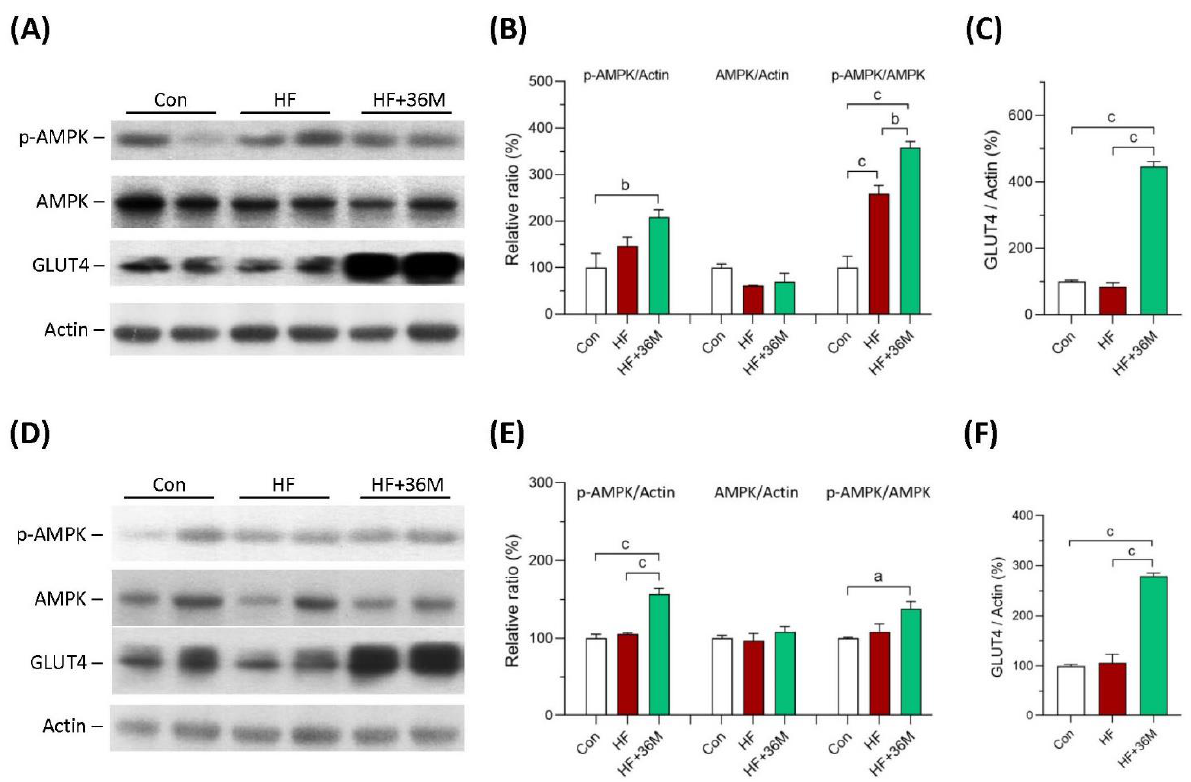
Figure 5. Protein expression of AMPK and GLUT4 in skeletal muscle of the mice. ( A ) The repre- sentative immunoblot images for p-AMPK, AMPK, GLUT4, and β -actin proteins of the mice in the prevention model. ( B , C ) The quantified results of the blots. ( D ) The representative immunoblot images for p-AMPK, AMPK, GLUT4, and β -actin proteins of the mice in the treatment model. ( E , F ) The quantified results of the blots. These protein expressions were detected by Western blotting. Con: control; HF: high-fat diet. Data are mean ± SE (n = 8). a: p < 0.05; b: p < 0.01; c: p <